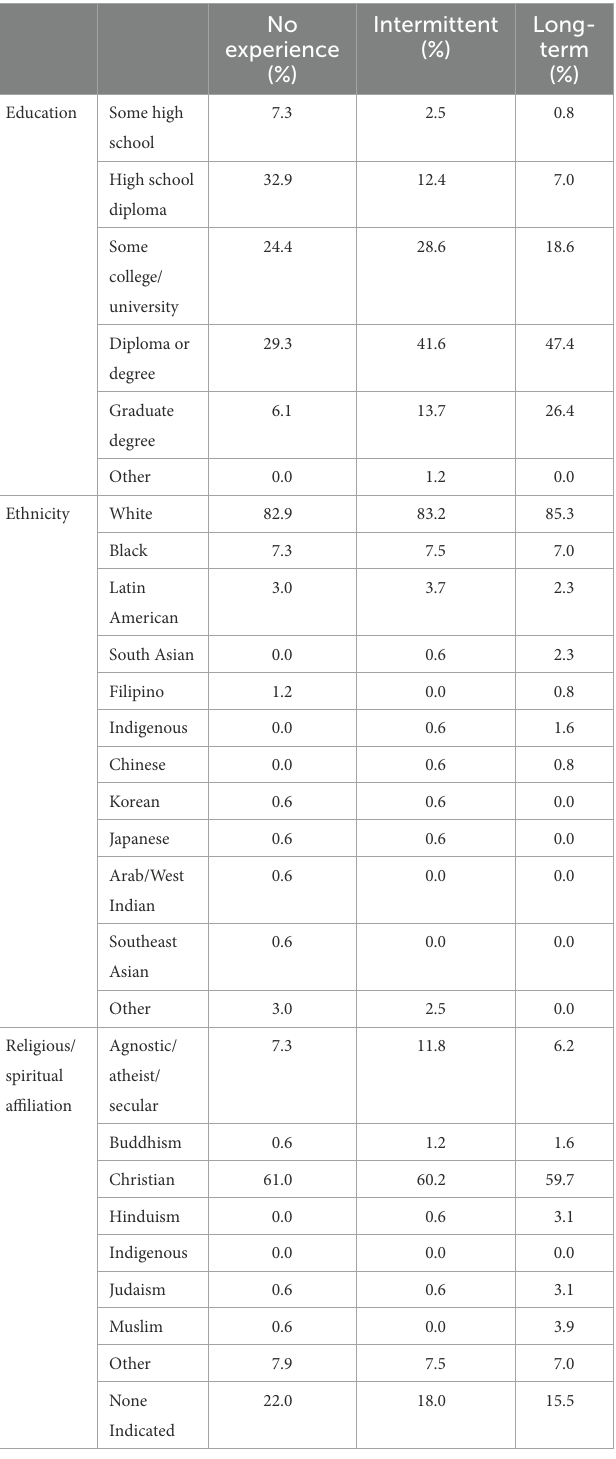
TABLE 2 Participant demographic information